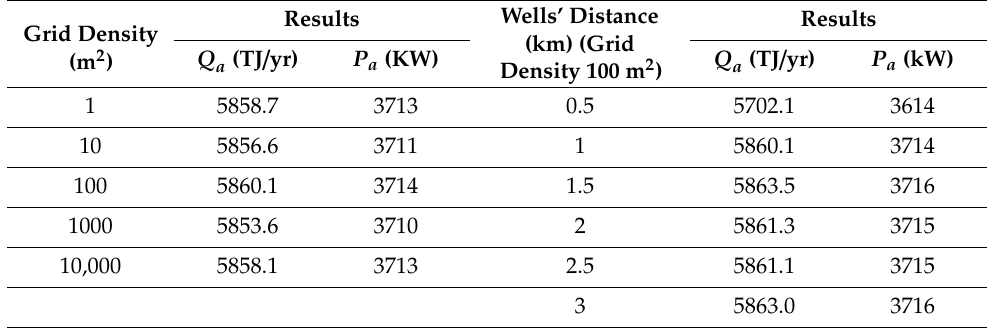
Table 2. Average amount of energy produced annually (TJ / yr) and averaged thermal power of the geothermal doublet—results in analyzed